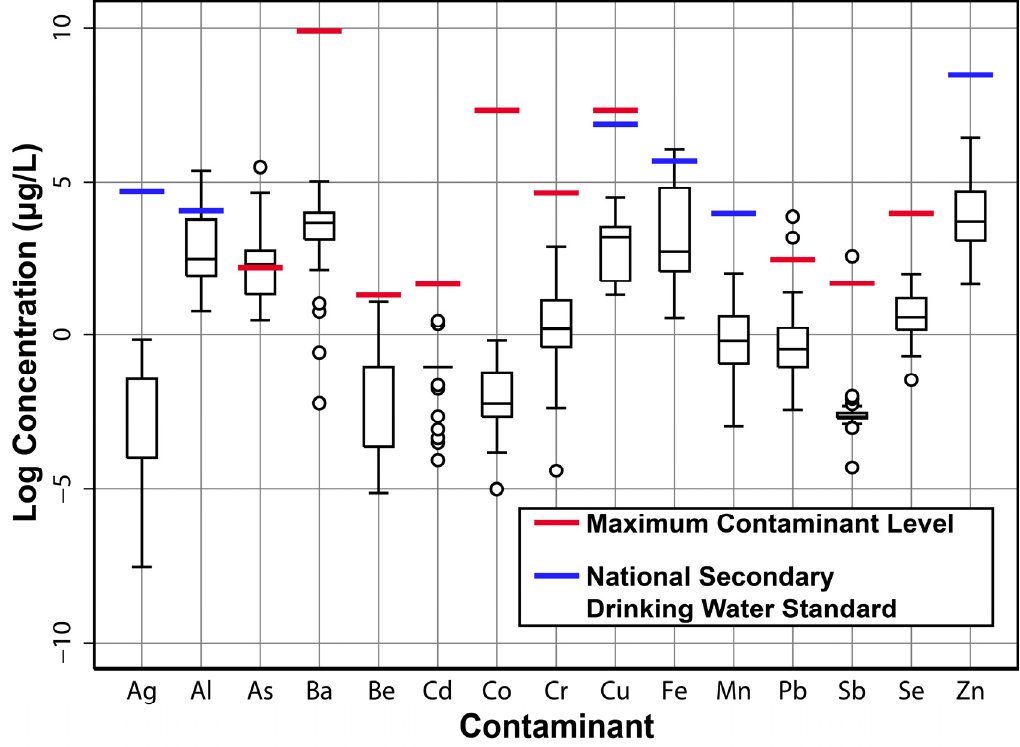
Figure 1. Distribution of contaminant levels in tap water samples without home treatment and their respective United States Environmental Protection Agency Maximum Contaminant Level (MCL) or National Secondary Drinking Water Regulation (NSDWR) guidelines (illustrated by red and blue solid lines, respectively). The median is represented by the line within the box; the 25th (Q1) and 75th (Q3) percentiles are represented by the lower and upper box bounds, respectively. The top whisker extends to include all data within 1.5 * interquartile range (IQR) of Q3, while the bottom whisker includes all data within 1.5 * interquartile range (IQR) of the Q1. Note: all 34 homes are shown including the three excluded from analysis because of missing home treatment